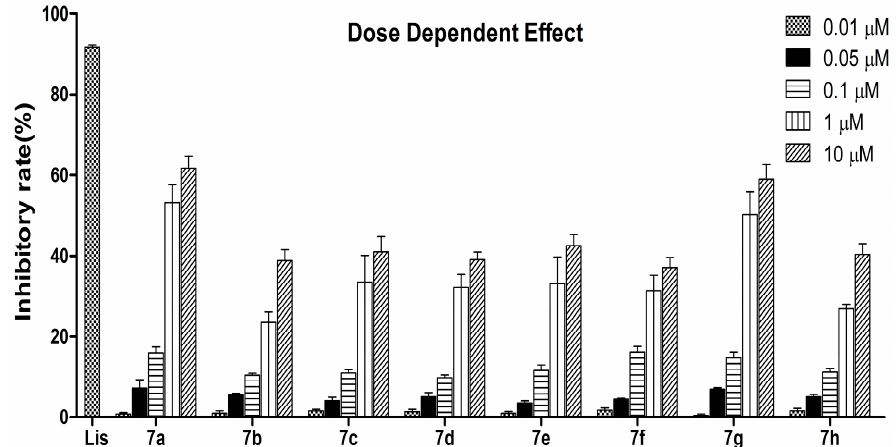
Figure 2 . Dose-dependent angiotensin converting enzyme (ACE) inhibition activity of test compounds and lisinopril (Lis). The results are presented as means ± SEM ( n = 8).